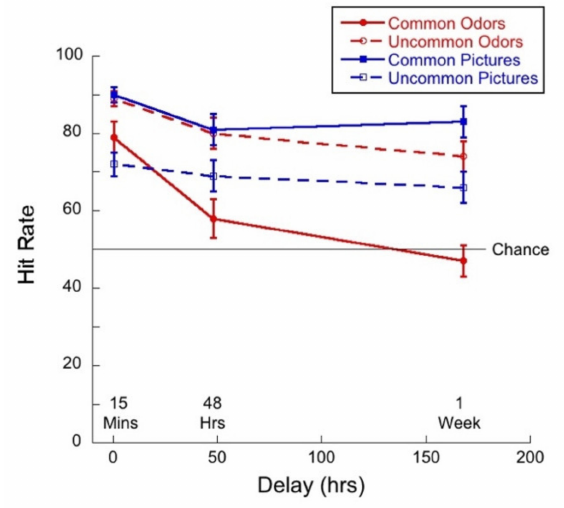
Figure 11. Hit rate as a function of delay for each of the four test conditions. Given that this was a “monadic” task, guessing would result in a hit rate of